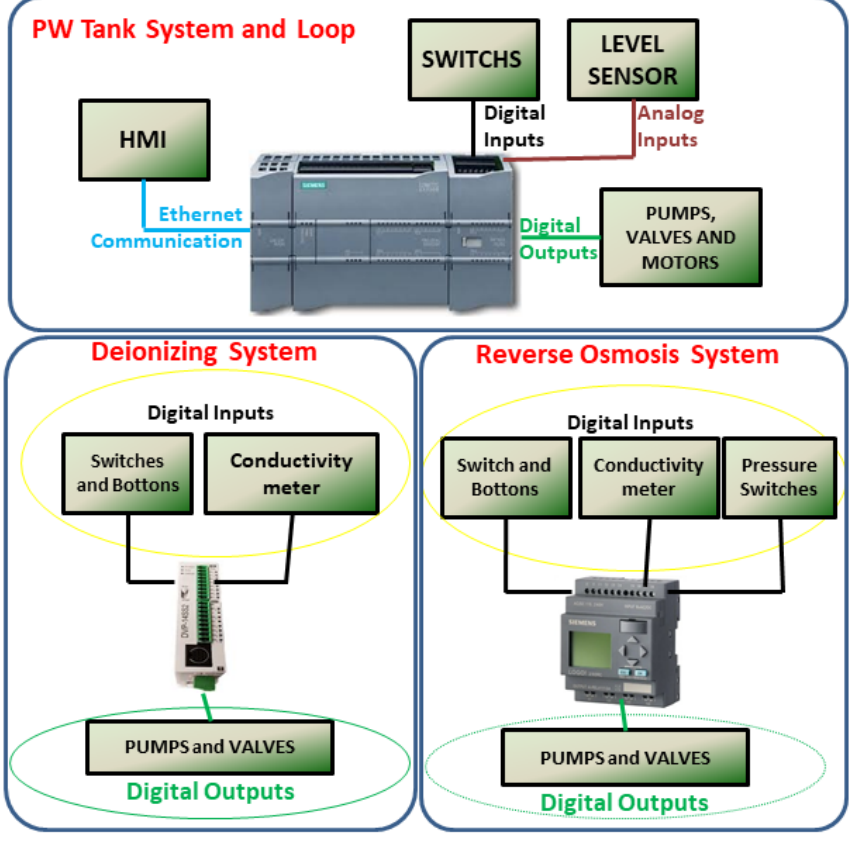
Figure 13. Decentralized systems before